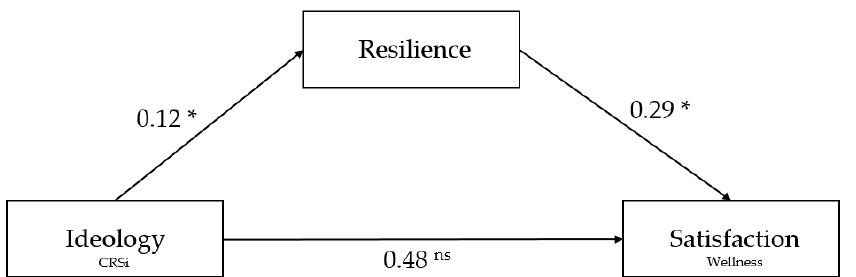
Figure 2. Standardized regression coefficients for the relationship between ideology and security and satisfaction mediated by resilience.* p < 0.05, ns non-significant, Wellness Students’ Wellness Scale, CRSi Interreligious Centrality of Religiosity